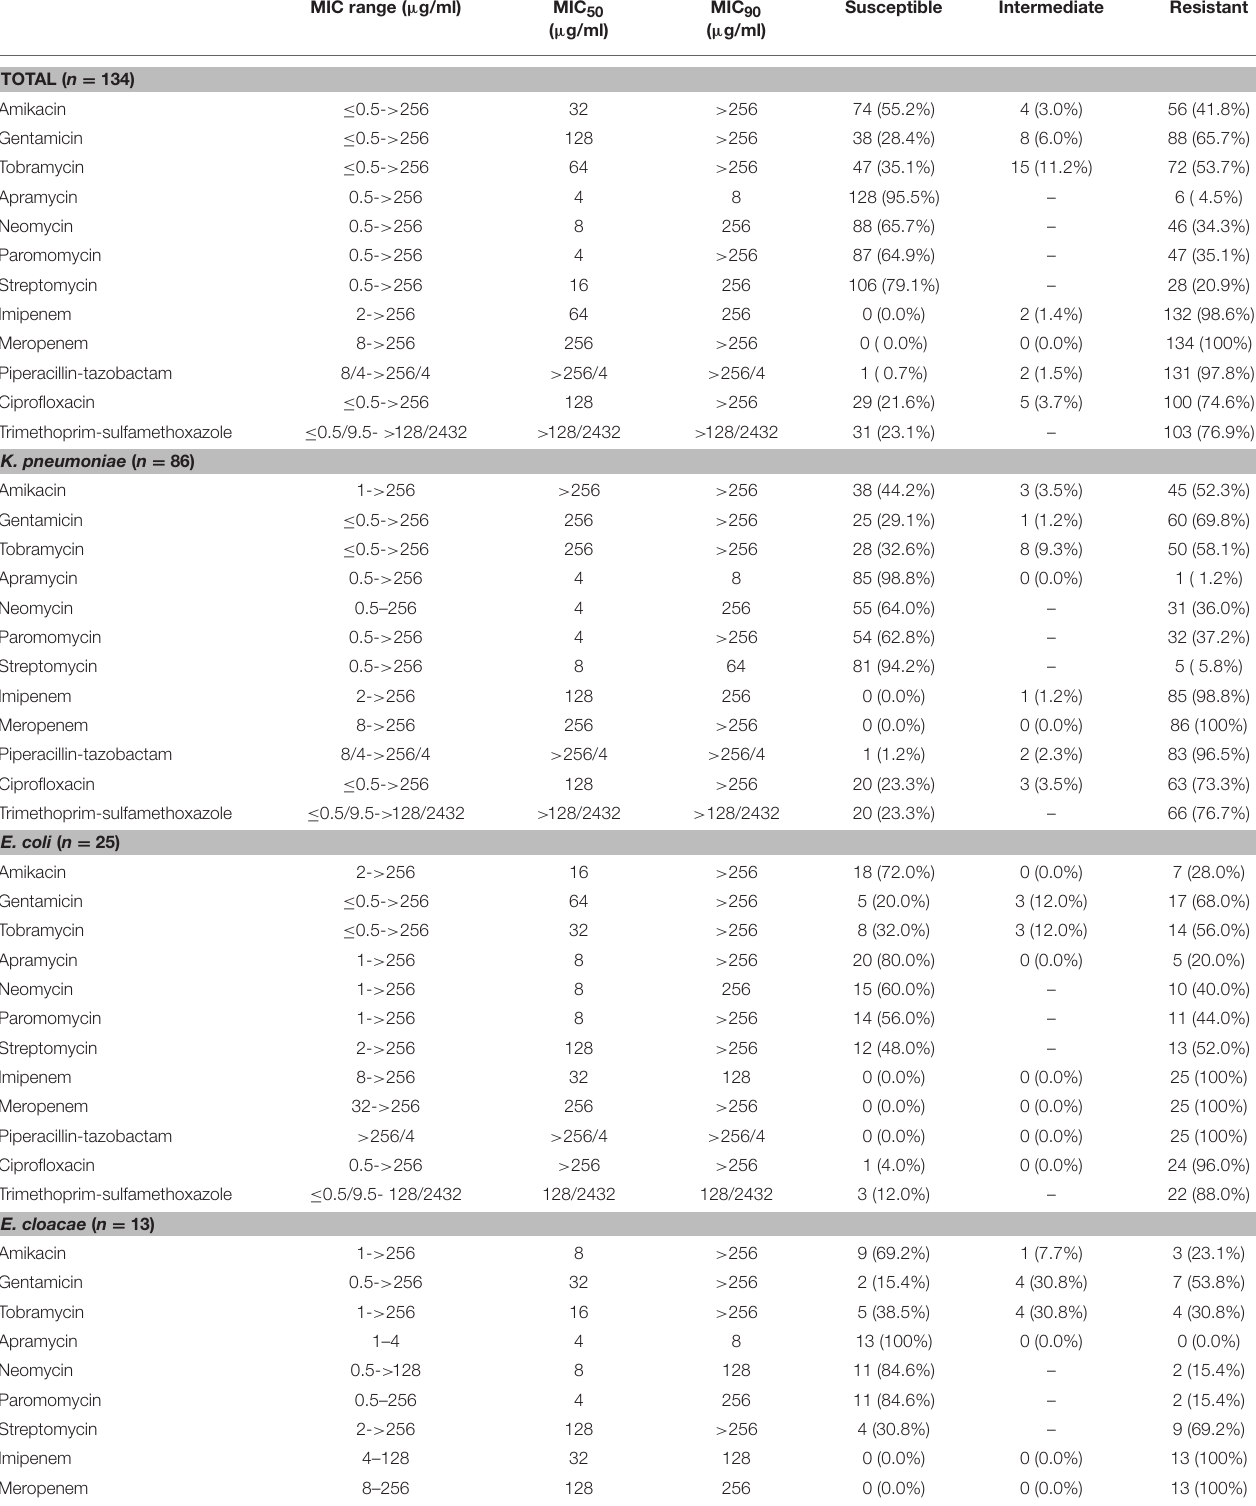
TABLE 2 | In vitro antimicrobial susceptibilities of CRE